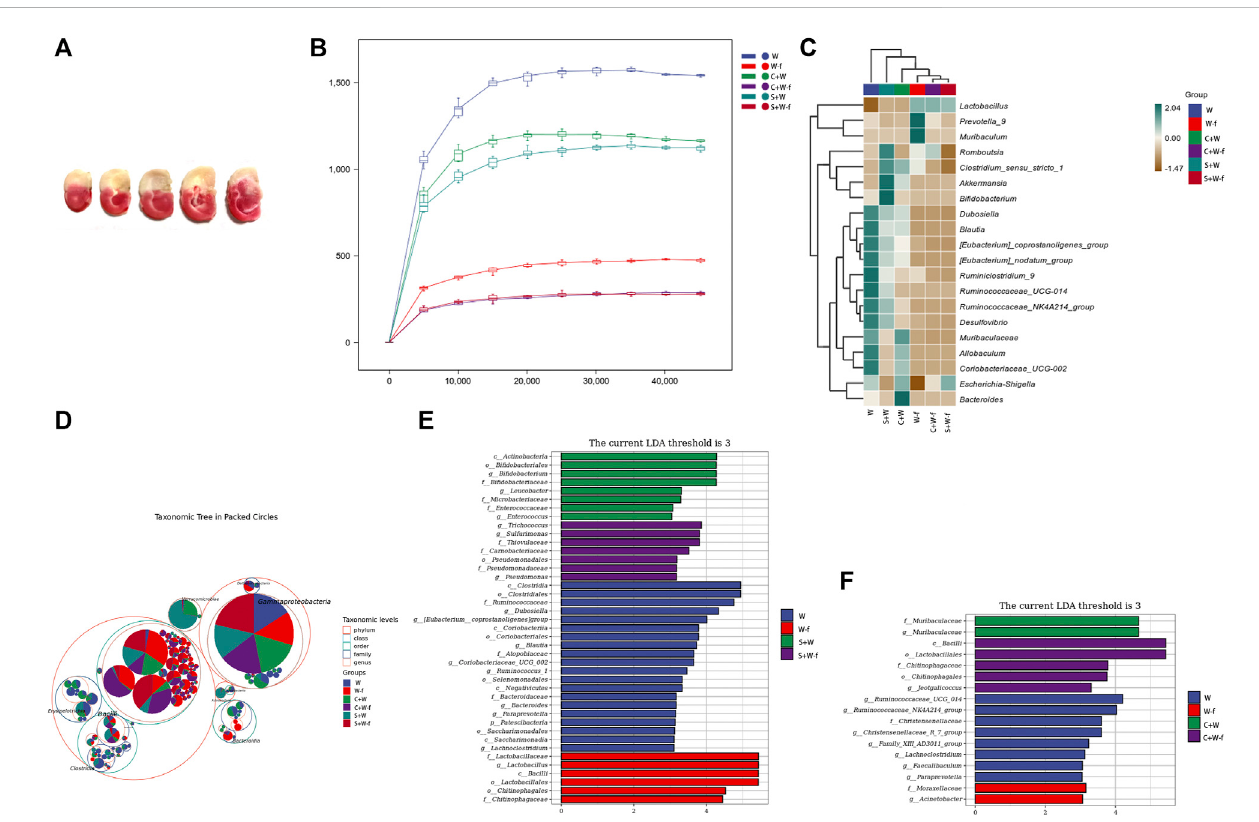
FIGURE 2 The TTC staining of the brain of MCAO rats and the results of 16S rRNA sequencing of the gut microbiota (A) The TTC staining of MCAO rats; (B) The rarefactioncurvesofChao1index; (C) Heatmapofthespeciescompositions; (D) Taxonomictreeinpackedcircles; (E,F) Thelineardiscriminantanalysis(LDA) effect size algorithm (LEfSe) analysis of the gut microbiota. W: MCAO rats with oral administration of warfarin; W-f: pseudo germ-free MCAO rats with oral administration of warfarin; C + W: MCAO rats with oral co-administration of warfarin and Chuanxiong Rhizoma; C + W-f: pseudo germ-free MCAO rats with oral co-administration of warfarin and Chuanxiong Rhizoma. S + W: MCAO rats with oral co-administration of warfarin and senkyunolide I; S + W-f: pseudo germ-free MCAO rats with oral co-administration of warfarin and senkyunolide